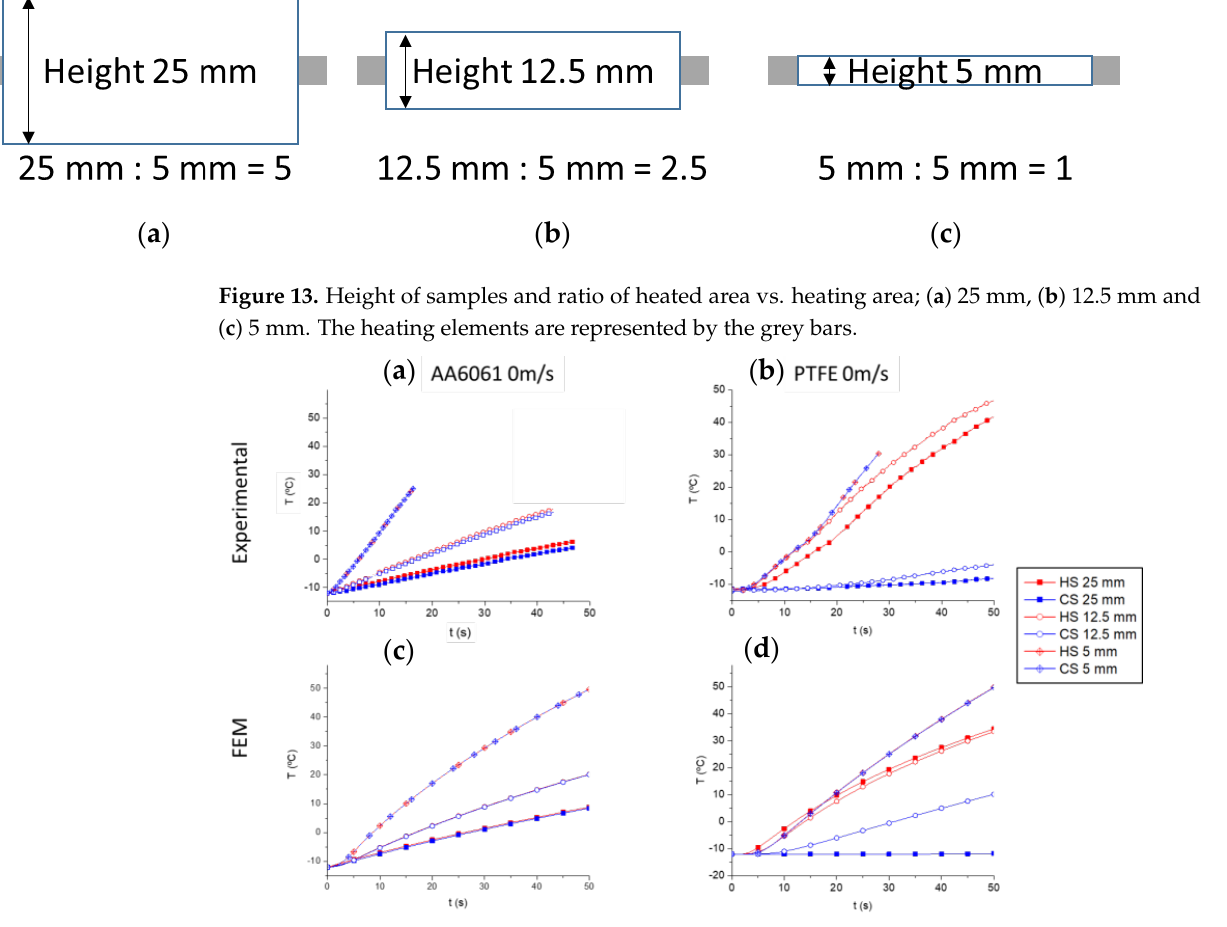
Figure 14. HS and CS temperature on different-sized samples under the 0 m/s condition. ( a ) AA6061. ( b ) PTFE. ( c ) Modeled AA6061 ( d ) Modelled